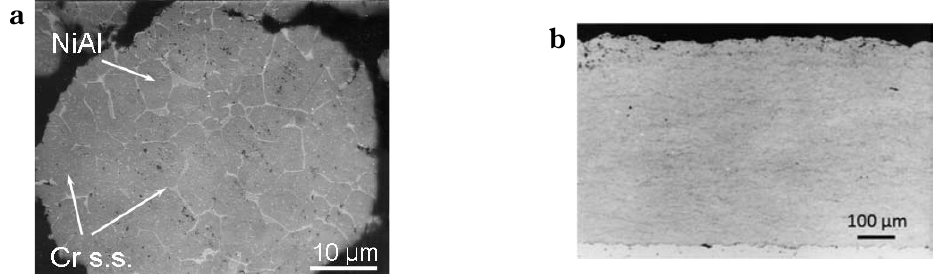
Fig.2 . Cross-sections of NiAlCr powder (a) and HVOF coating from it